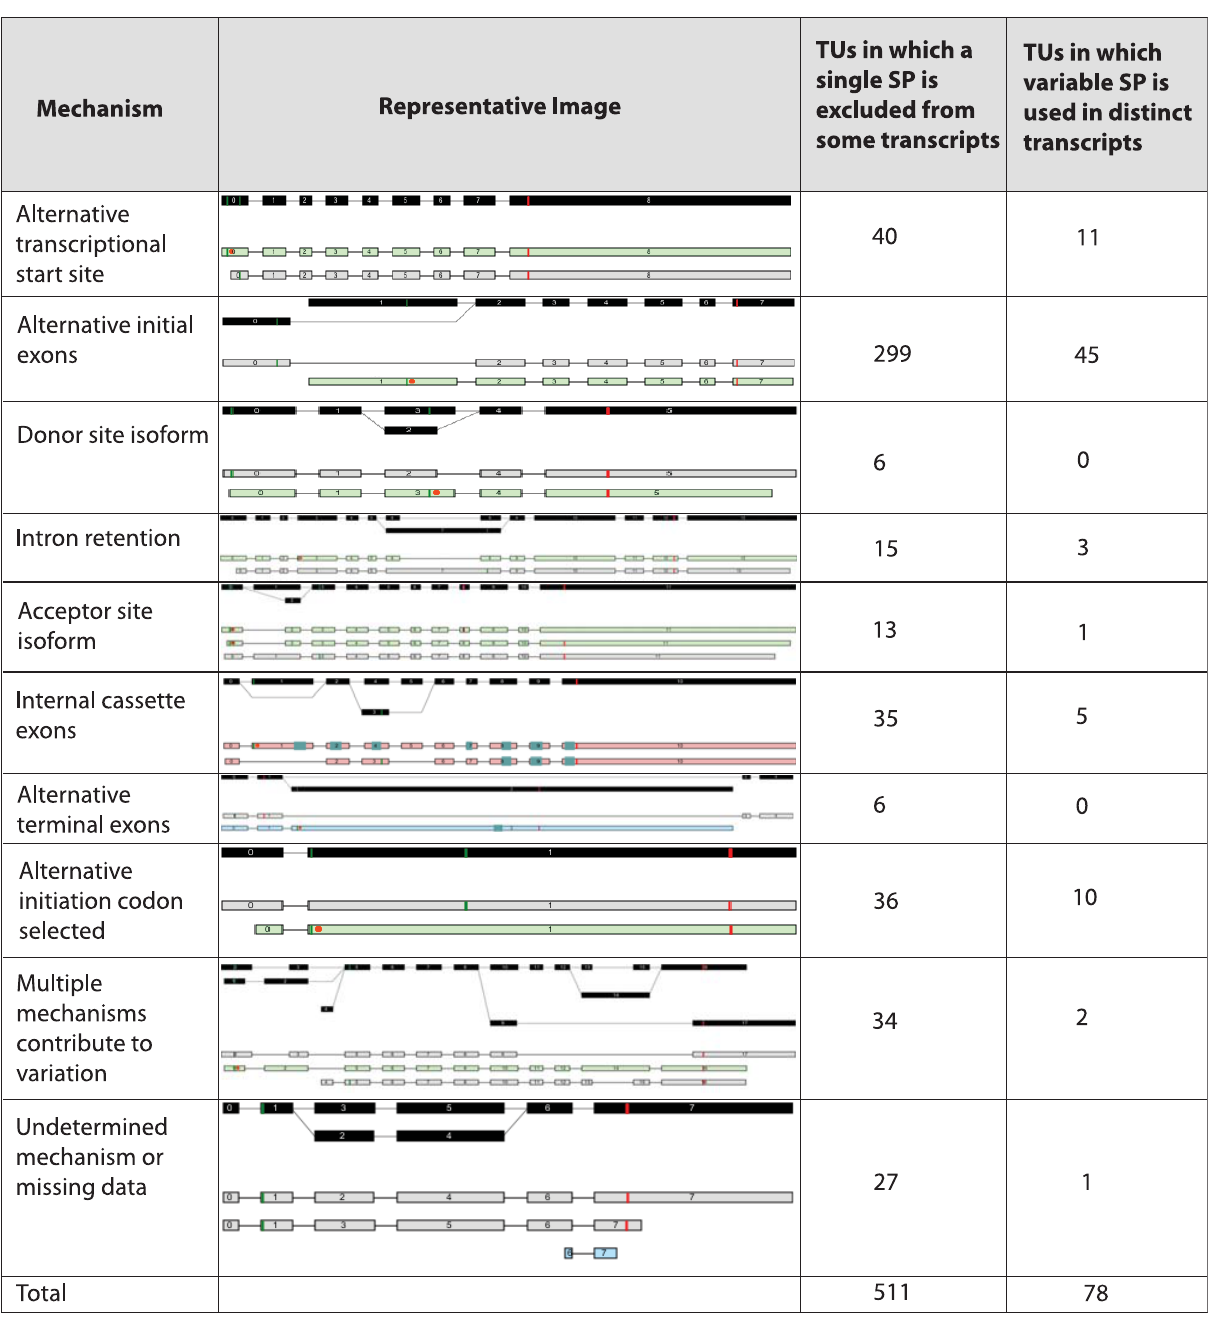
Figure 1. Variation of Signal Peptide by Transcript Variation and Alternative Splicing Sixteen TUs are represented in both categories. These TUs contain multiple transcripts using signal peptide coding regions generated from distinct regions of the genome while alternative transcripts within the same TU exclude these signal peptide coding regions altogether. Thin green and red bars across exons represent the location of the start and stop codons respectively. An orange dot following the start codon represents the presence of N- terminal signal peptide, while green blocks show the genomic localization of the predicted transmembrane domain features within exons. DOI: